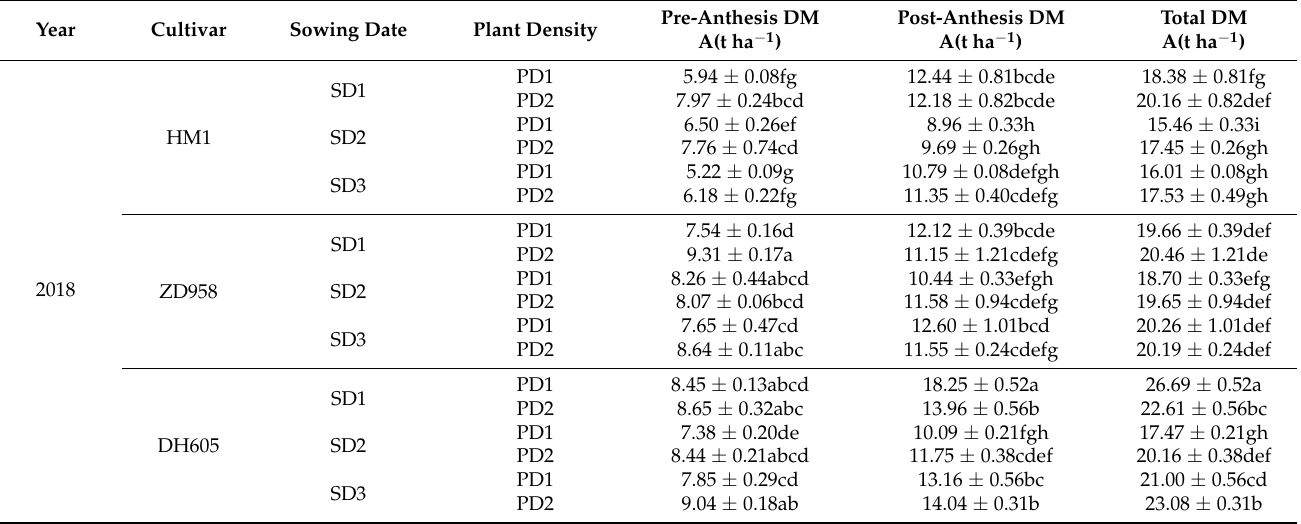
Table 4. Effects of cultivar, sowing date and plant density on pre-anthesis, post-anthesis, and total DMA of summer